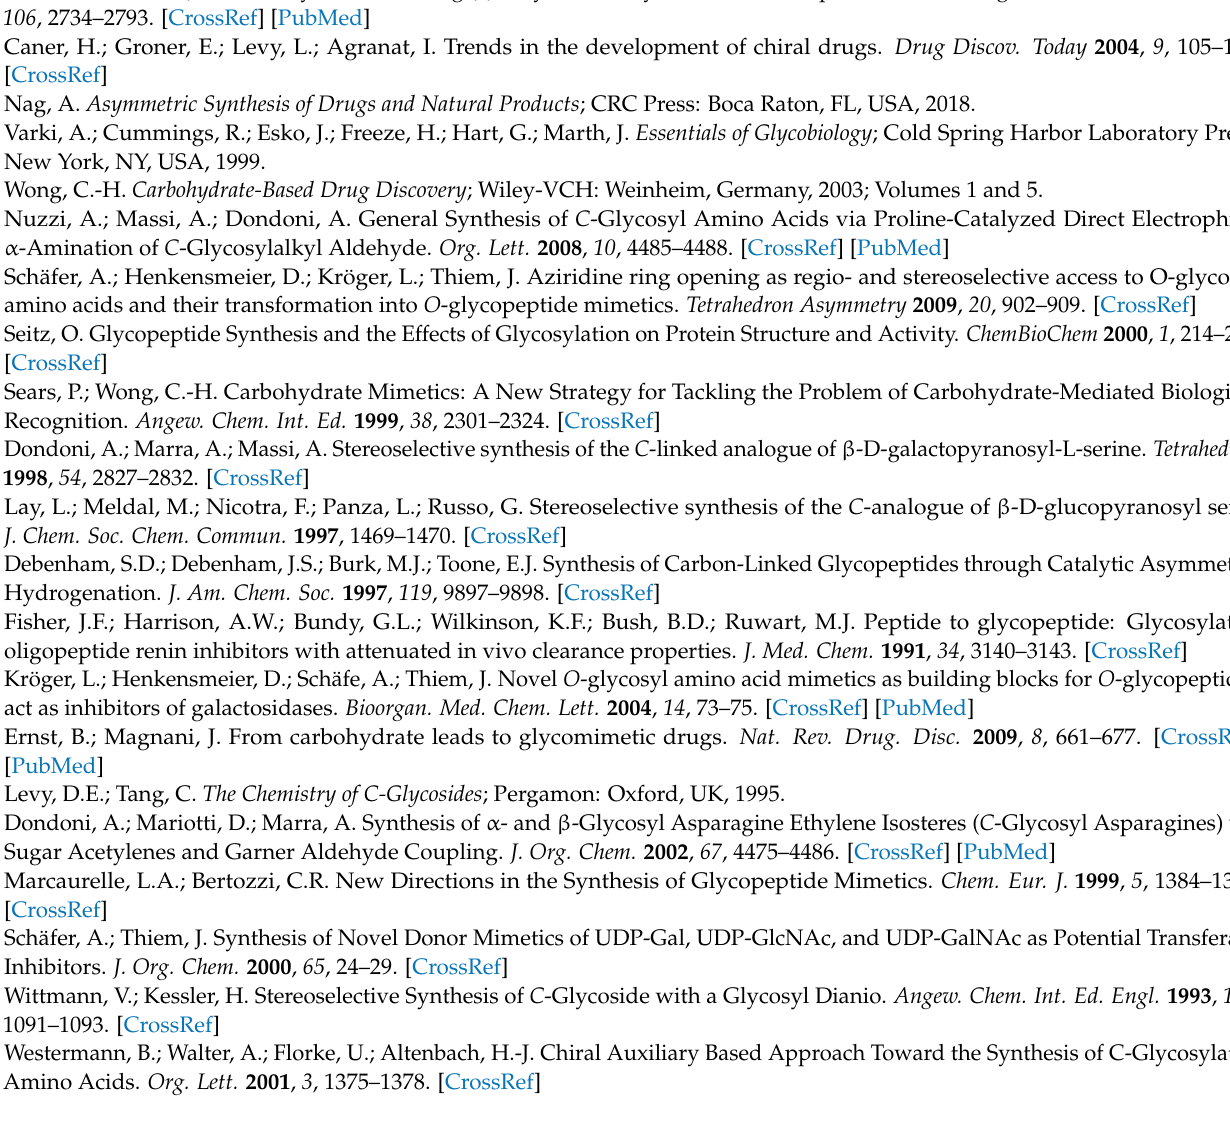
18 , Figure S20: 13 C NMR (150 MHz, CD 3 Cl) spectrum of 18 , Figure S21: 1 H NMR (600 MHz, CD 3 Cl) spectrum of 19 and 20 , Figure S22: 13 C NMR (150 MHz, CD 3 Cl) spectrum of 19 and 20